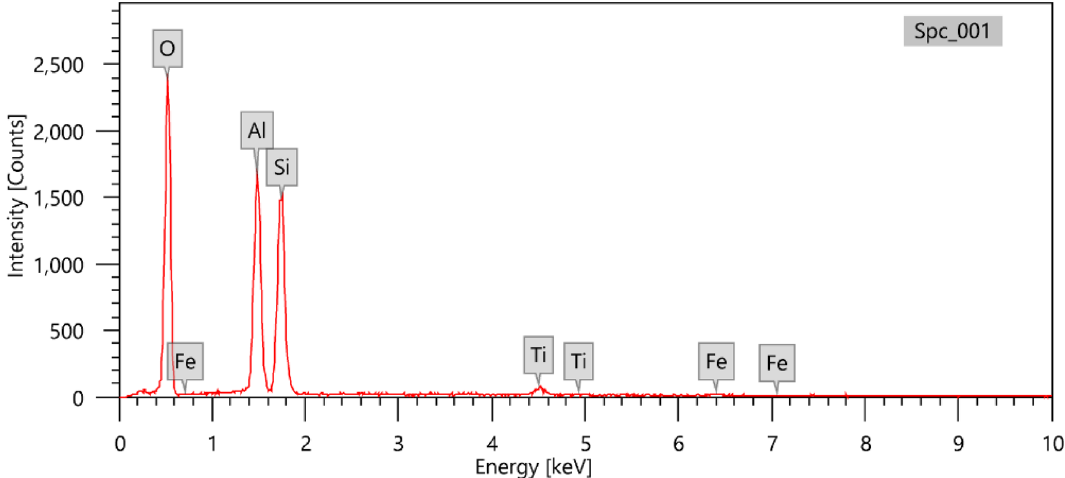
Figure 1. Energy dispersive X-ray (EDX) analysis of the kaolinitic clay sample.